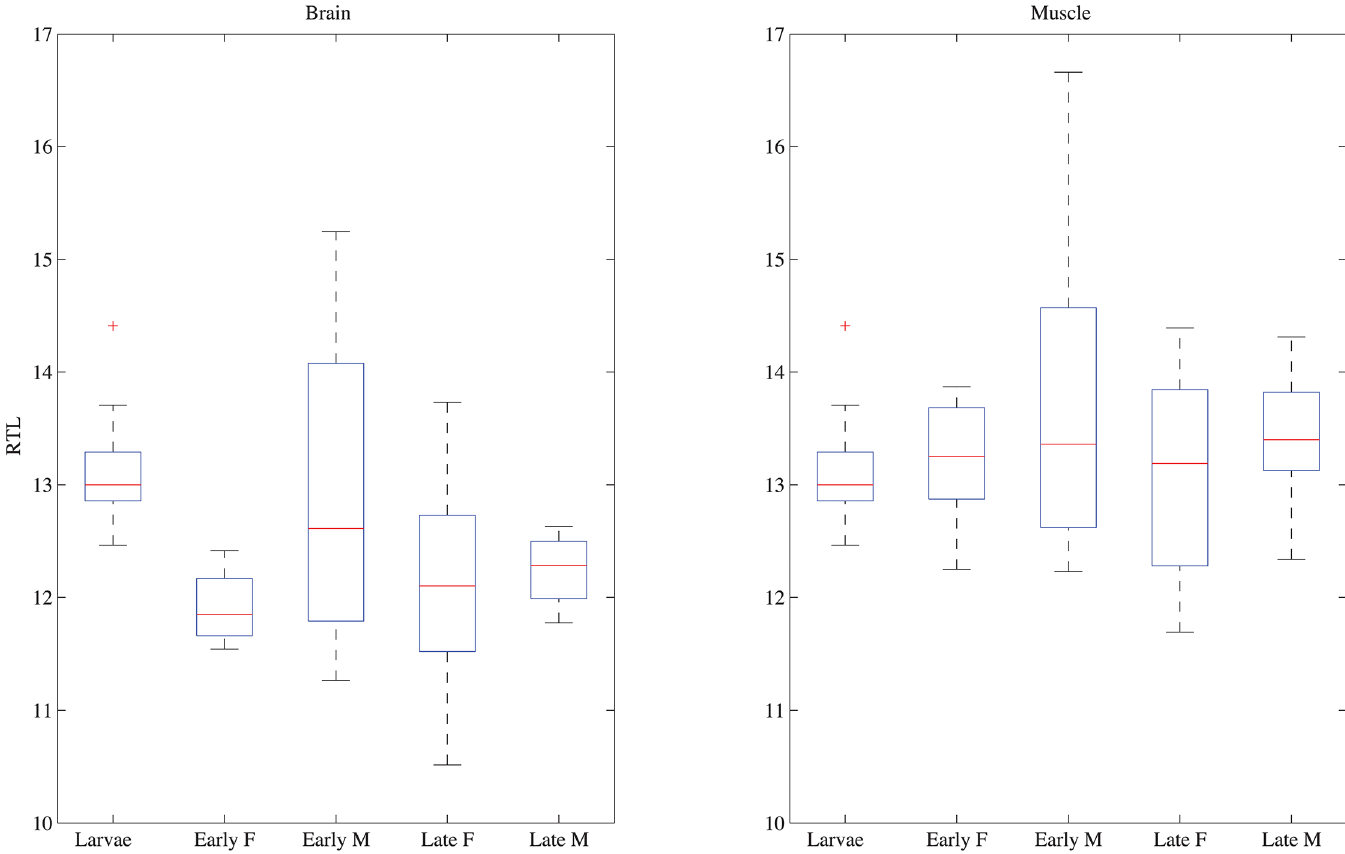
Fig 1. Telomere length through time. The relative telomere length is reported for larvae (age 1 D), females and males from the early breeding period, age 150 days (Early F and Early M respectively), and females and males from late breeding period, 200 days (Late F and Late M respectively). The left panel indicates results for brain tissue and the right panel indicates telomere lengths for muscle. The red line for each box indicates the mean, box edges indicate 25% and 75% percentile, and the whiskers show outlier outside +/-2.7 standard deviation.